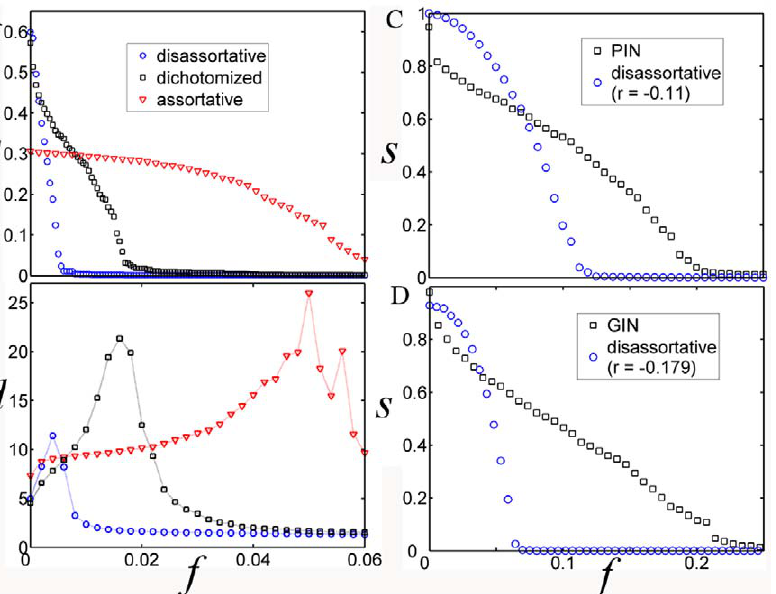
Figure 6. Robustness and interconnectivity of the network under targeted attacks. A . Comparison of the size of the largest component between disassortative, assortative and dichotomized network models, each containing 10,000 nodes with P ( k ) , k 2 2.4 . B . Comparison of network diameter as a function of the fraction f of removed best connected nodes. Note that the size of the largest component of unperturbed dichotomized network ( f =0) is larger than that of assortative network, while the diameter is smaller than it, indicating that the dichotomy of degree correlation generates a more interconnected web. C . The size of the largest component in function of f , between PIN of HC dataset and a random network with similar level of anti-correlation (generated by rewiring links of PIN and by setting the parameter p =0.05, see materials and methods). D . The same as C but between GIN and a random network with similar level of anti-correlation (generated by setting the parameter p =0.1).